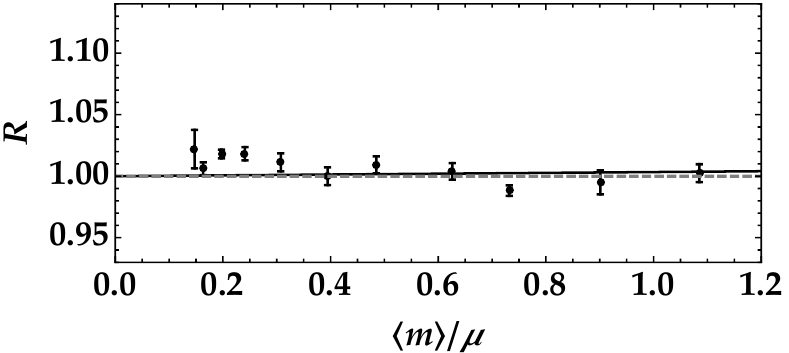
Figure 10. R as a function of the mean number of photons per mode for µ = 1.08 ± 0.02. The data are shown as black dots + error bars, while the theoretical curve according to Equation (6) is shown as a black line. From the fitting procedure, we obtain t = 0.92 ±